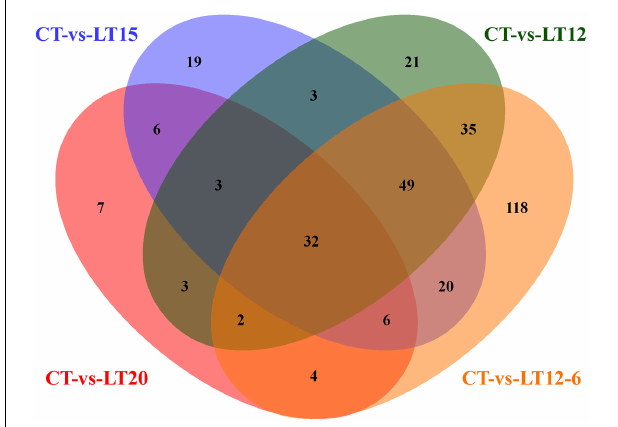
FIGURE 8 | Number and intersection of DE miRNAs in pairwise comparisons between the control group and four low-temperature groups.